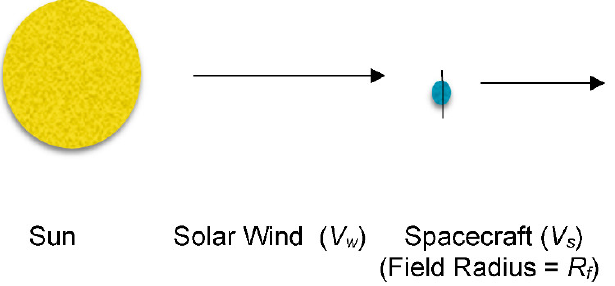
Figure 1. Starship acceleration by electric sail.